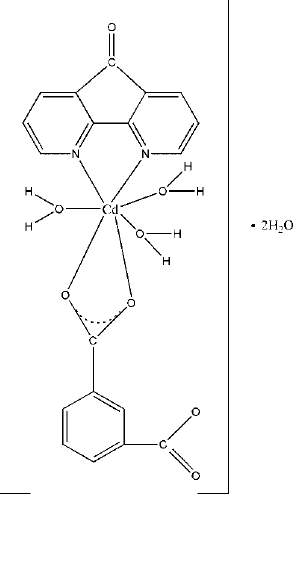
Bruker APEXII diffractometer Absorption correction: multi-scan